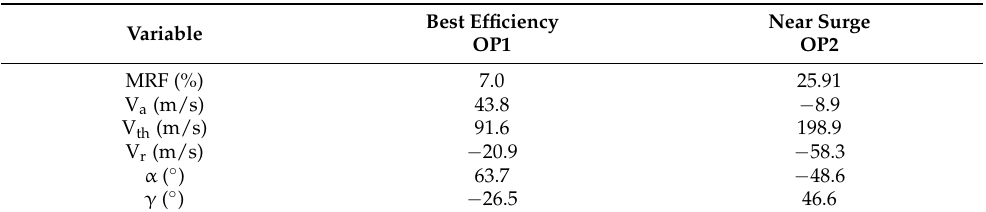
Table 3. Main flow characteristics exiting from section A of the cavity at the conditions OP1 (best efficiency) and OP2 (near surge).